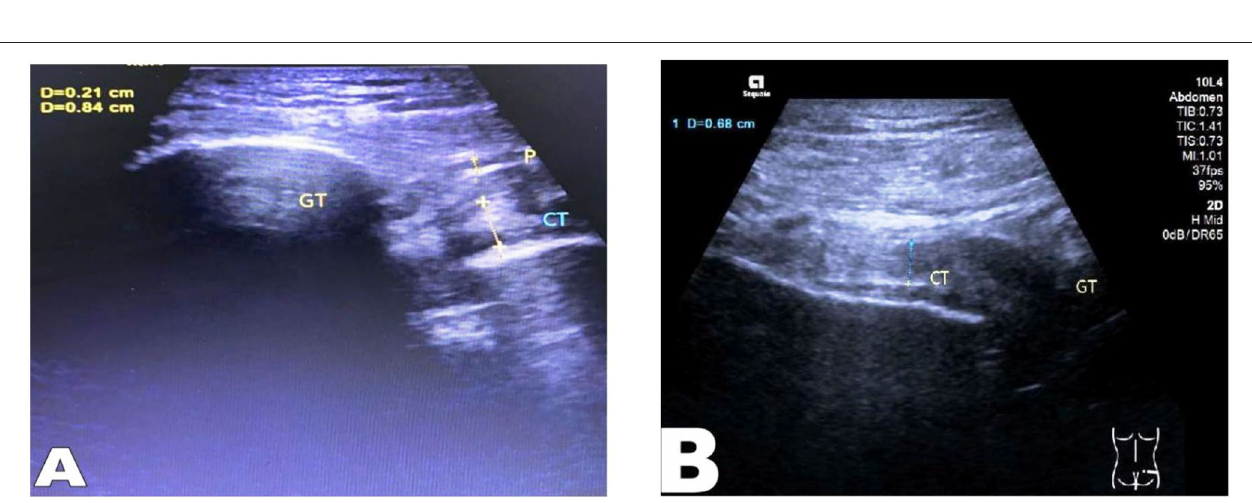
Frontiers in Surgery |